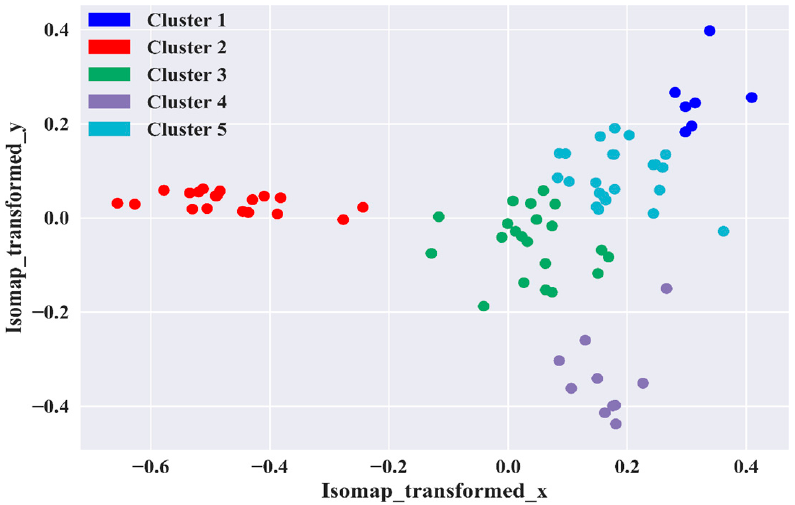
Figure 5. Plot of clustered cities using ISOMAP and K-means clustering. Figure 4. Plot of clustered cities using ISOMAP and K-means clustering. Table 3. Five classes of World Urban Road Networks. Table 3. Five classes of World Urban Road Networks.